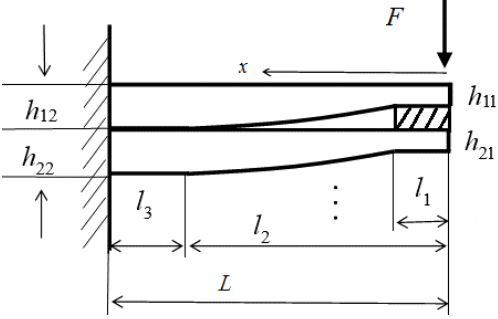
Figure 3. The mechanical model of the taper-leaf spring including n pieces.